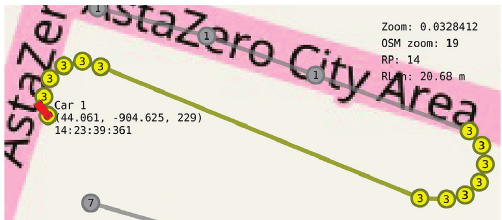
Figure 9: Trajectory generated by extending arcs from a starting point-orientation (the car) to a goal point-orientation (the recovery trajectory (trajectory 1)).